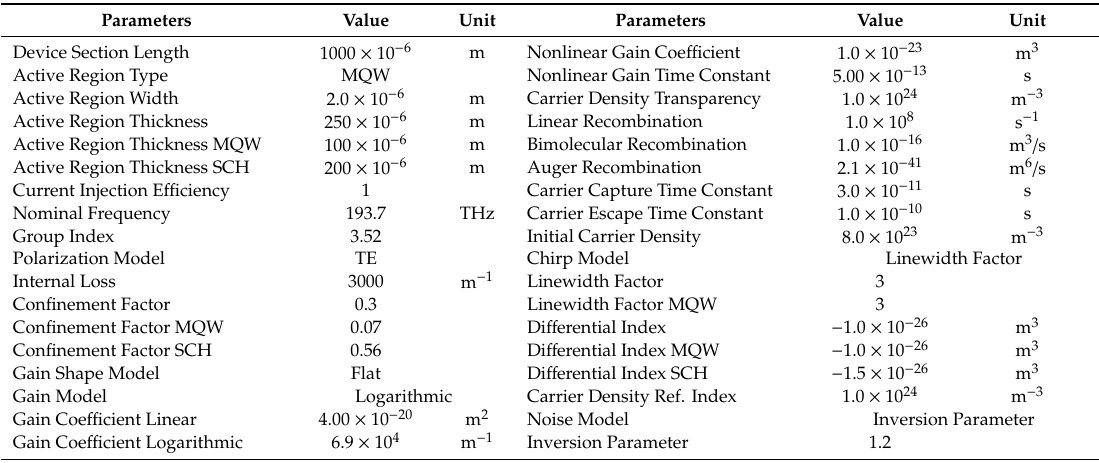
Figure 2. Photonic deep neural network (PDNN) simulation scheme on software VPIphotonics . ( a ) System for examining the PDNN. ( b ) Arbitrary waveform generator. ( c ) Lasers and modulators. ( d ) Receiver. ( e ) One photonic weighted addition unit (part of the matrix multiplication unit, MMU). Table 1. The parameters used in the simulation of SOA.